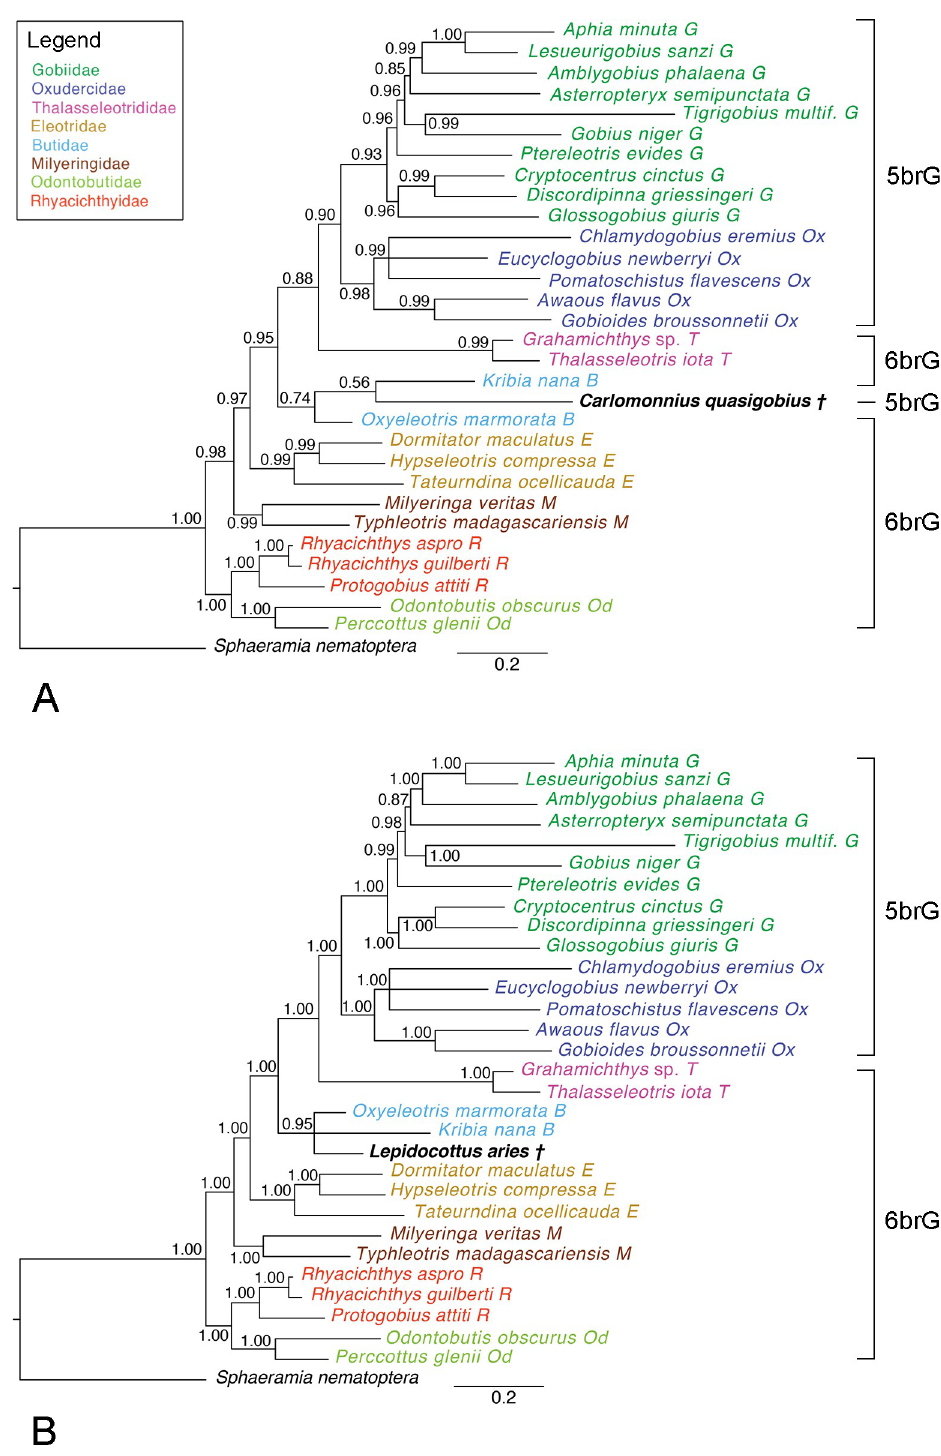
Fig 6. 50% MRC Bayesian trees with posterior probabilities based on the total-evidence dataset. A † Carlomonnius quasigobius was added to the extant species (ASDSF = 0.003939). B † Lepidocottus aries was added to the extant species (ASDSF = 0.000854). Scale bars, average number of substitutions per site respectively character changes per character.